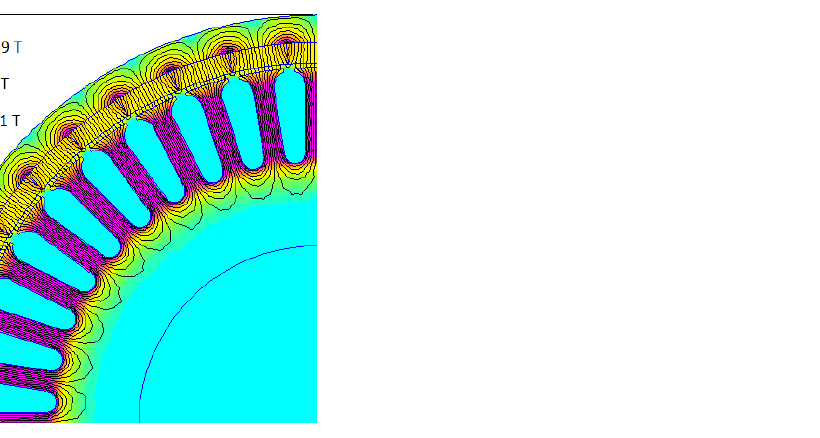
Figure 7. The shape of magnetic lines forces in a proposed flat core design.